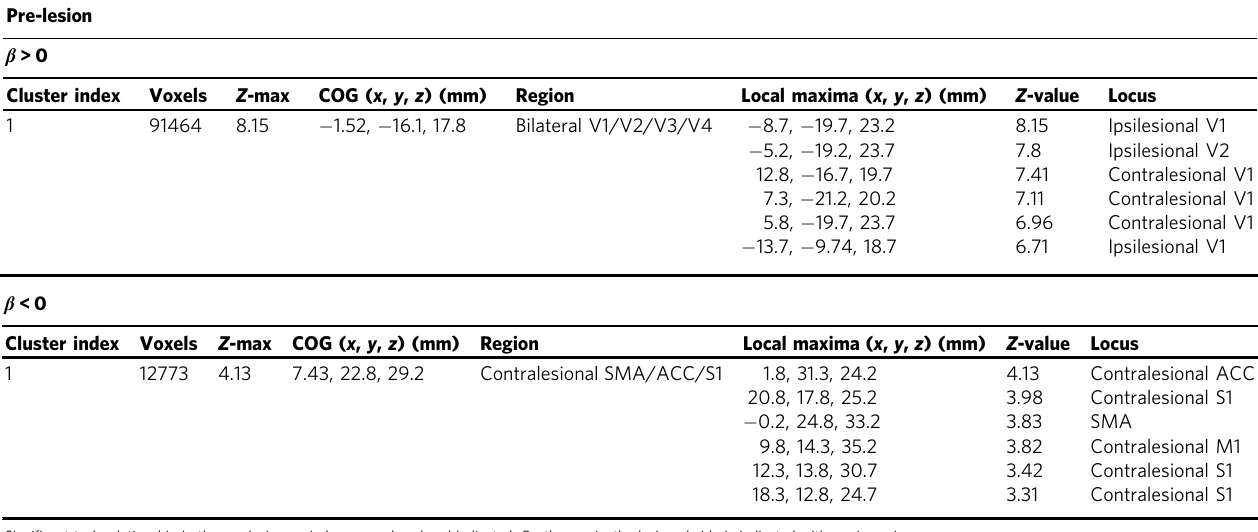
Table 1 Whole-brain statistical analysis of rCBF changes related to task condition: pre-lesion period.